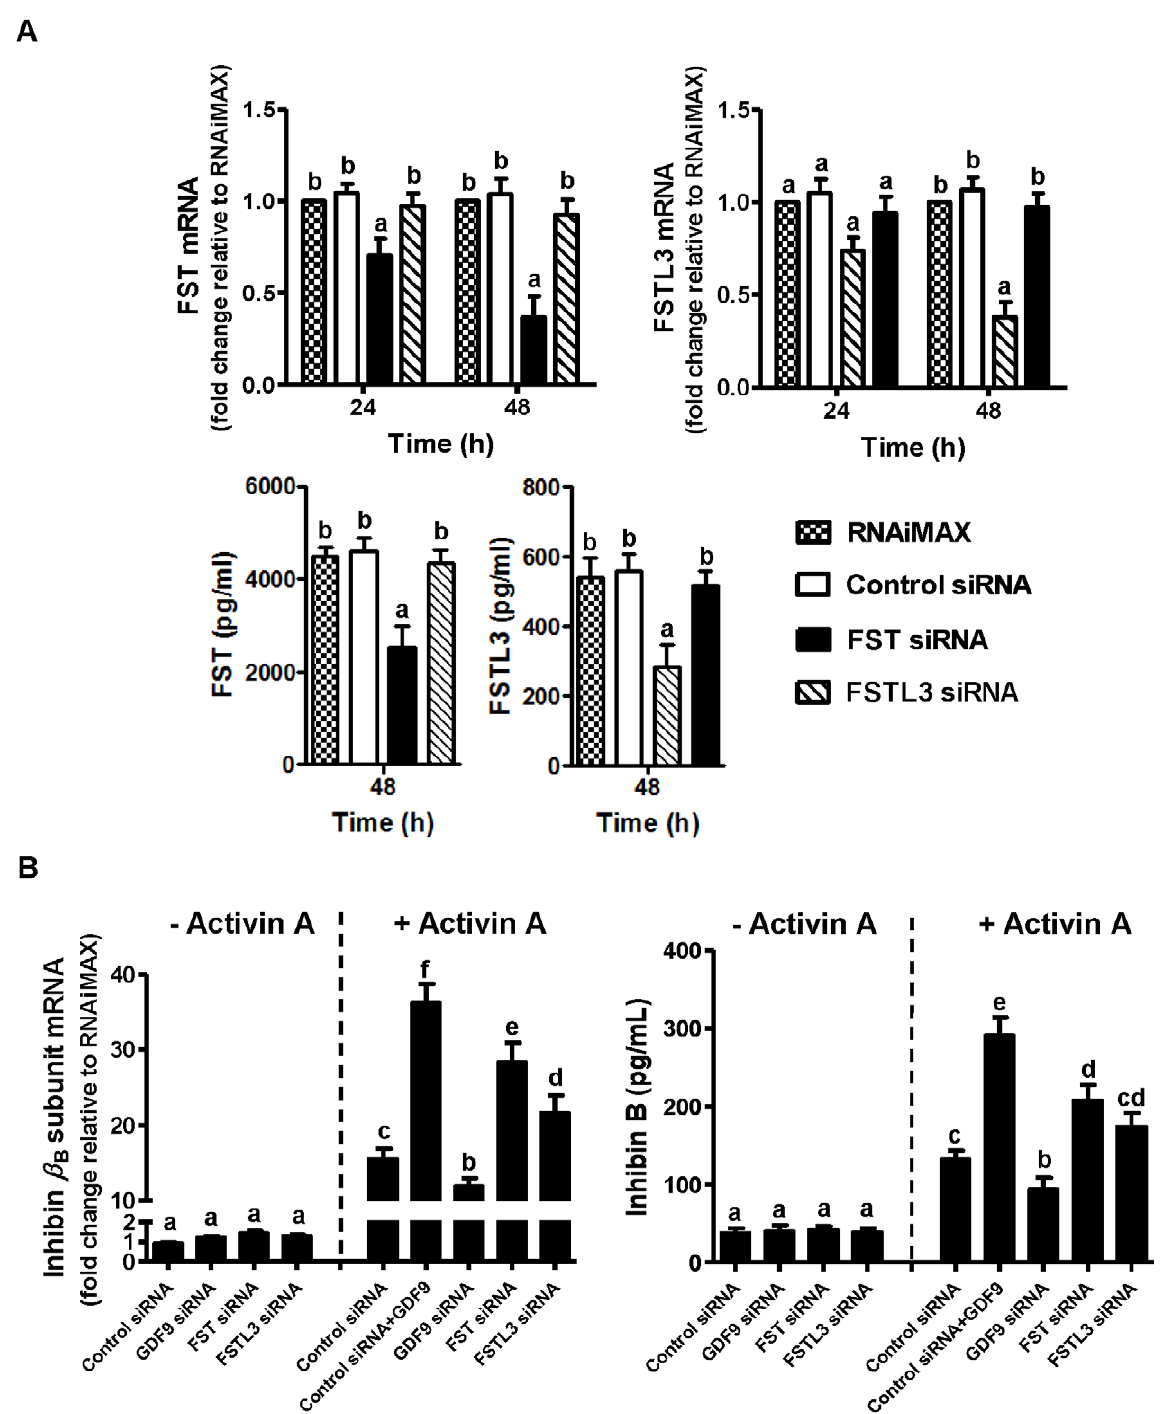
Figure 4. GDF9-targeting siRNA attenuated while FST/FSTL3-targeting siRNA enhanced activin A-induced inhibin b B -subunit and inhibin B expression. A: After preculture for 48 h, hGL cells were transfected with 80 nM of non targeting siRNA (‘‘Control siRNA’’) and FST- or FSTL3-targeting siRNA for 24 h (‘‘Time 24 h’’) and 48 h (‘‘Time 48 h’’). FST and FSTL3 mRNA levels in hGL cells ( upper panel) and protein concentrations in culture media ( lower panel) were assessed by real-time PCR and ELISA, respectively. Results were the means 6 SEM from at least four sets of experiments (each from a separate patient), and in each set, measurements were made in triplicate for real-time PCR or duplicate for ELISA. At each time point, means without a common letter are significantly different ( P , 0.05). B: After preculture for 48 h, hGL cells were transfected with 80 nM of control siRNA and GDF9-, FST- or FSTL3-targeting siRNA for 48 h. The culture media were then replaced by low-serum media (0.5% FBS), and hGL cells were cultured with and without 100 ng/ml GDF9 for another 24 h before treatment with 25 ng/ml activin A for 24 h. Inhibin b B - subunit mRNA levels in hGL cells and inhibin B protein levels in culture media were measured by real-time PCR and ELISA respectively. Results were the means 6 SEM from at least four sets of experiments (each from a separate patient), and in each set, measurements were made in triplicate for real-time PCR and duplicate for ELISA. Means without a common letter are significantly different ( P , 0.05). doi:10.1371/journal.pone.0022866.g004 PLoS ONE |